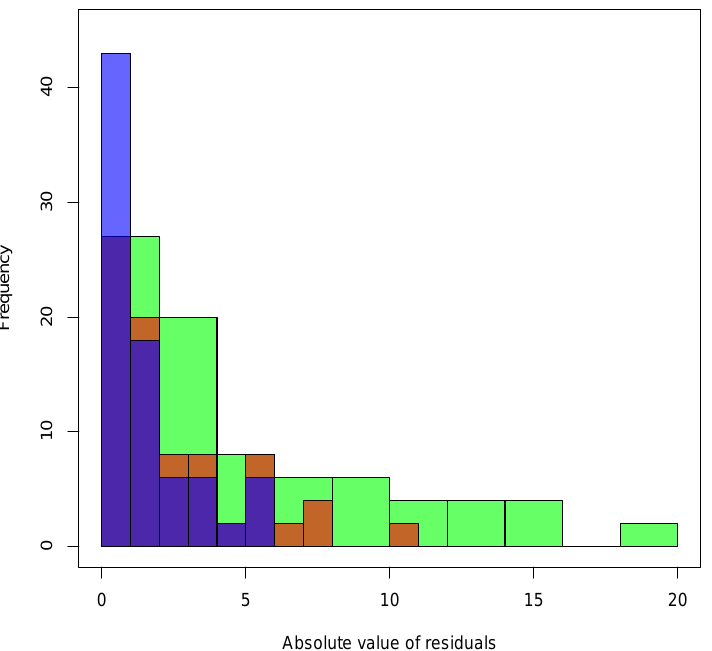
Figure 4. Histograms of the absolute values of the residuals for one-dimensional MDS (green), two-dimensional MDS (red), and tree estimation (blue) for the justices on the 2018–2019